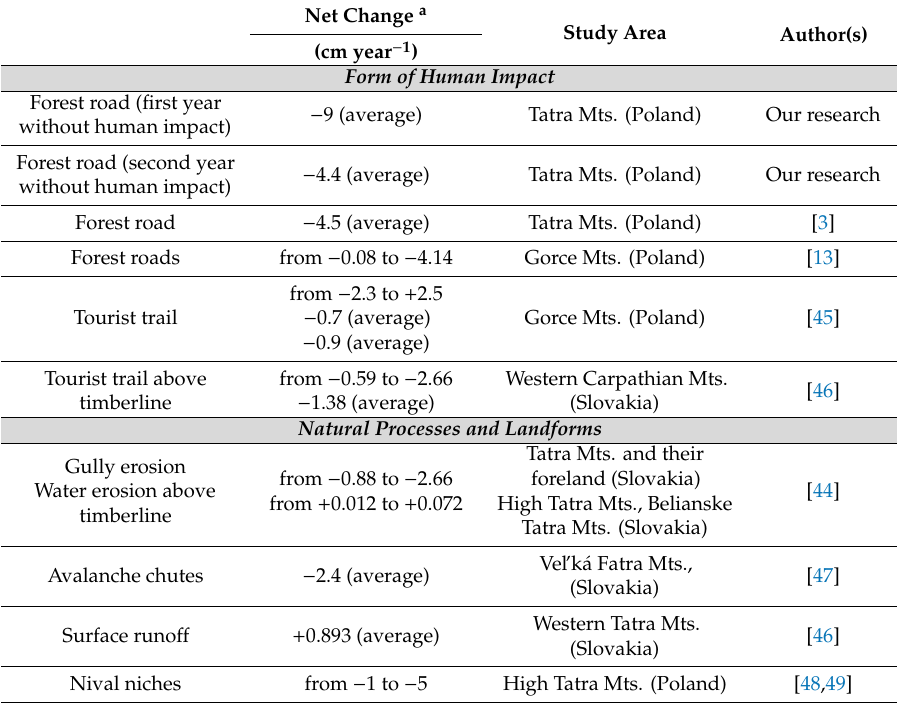
Table 2. Erosion rates for the studied forest road and other data in the Carpathian